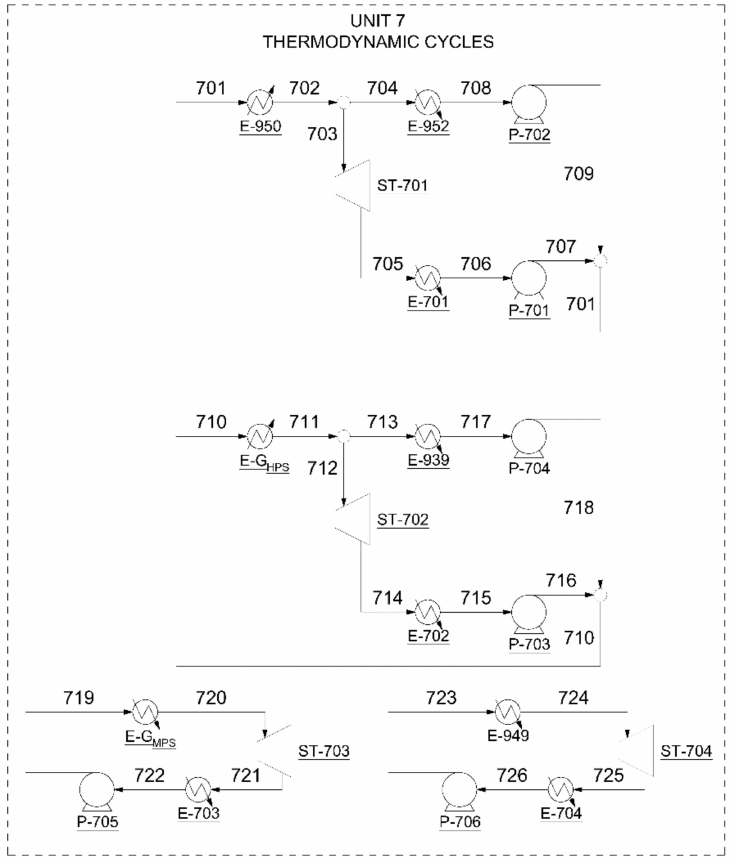
Figure 9. Rankine cycles (unit 7).